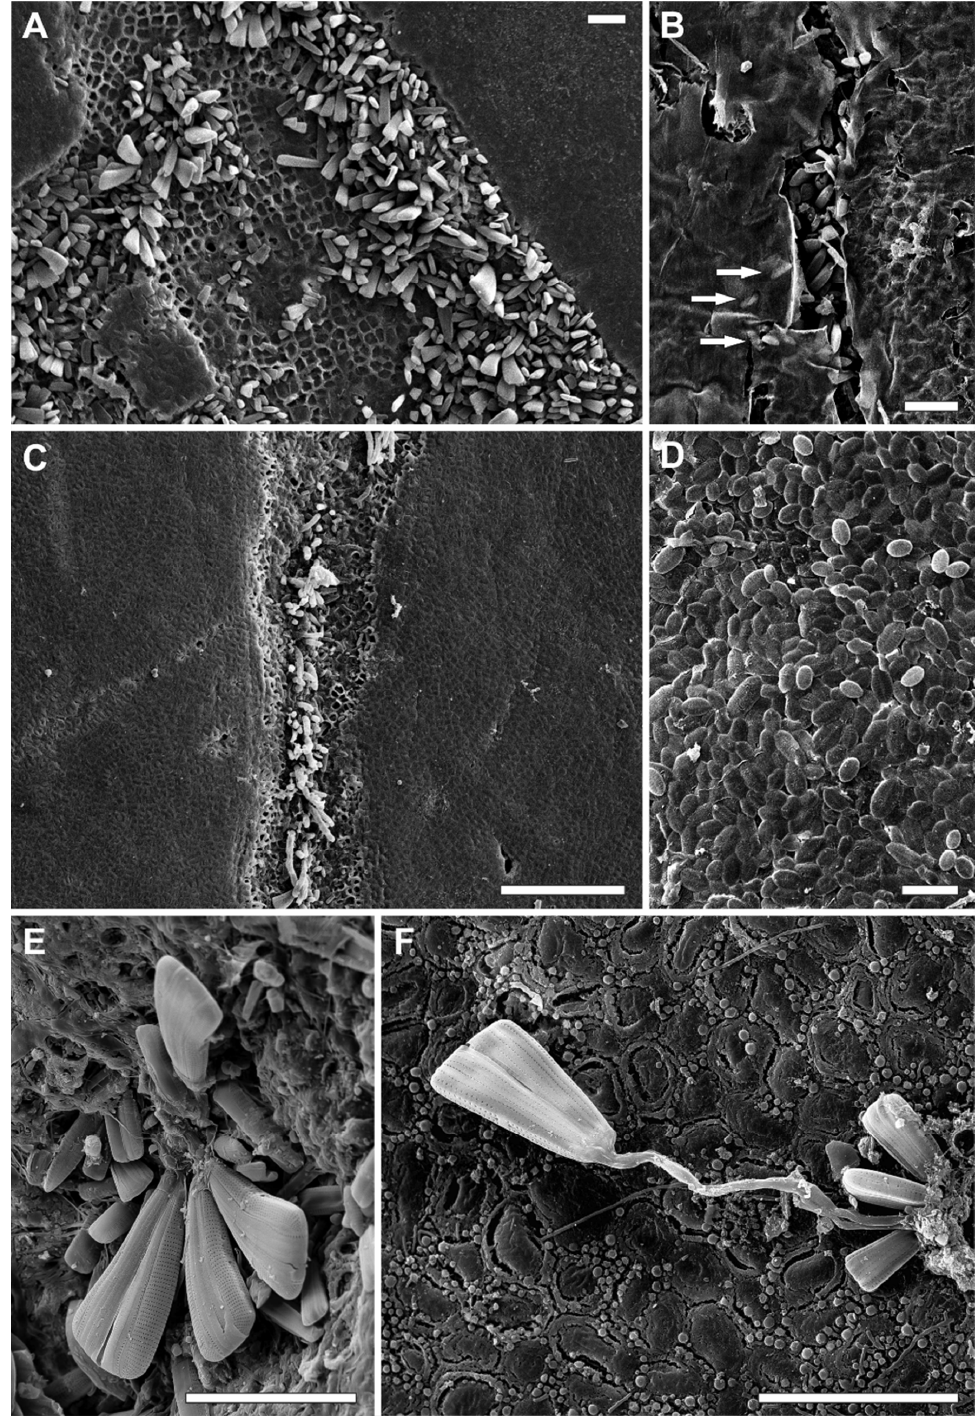
Figure 3. Scanning electron microscope (SEM) micrographs showing diatom assemblages on South African kelps. ( A – C and E ) Diatoms colonising cracks in the surface layer. ( B ) Diatoms underneath the flaking kelp tissue. Arrows indicate diatoms completely covered by the thin sloughing layer. ( D ) Cocconeis costata colonising the smooth surface of the kelp thallus. ( E ) Rhoicosphenia flexa , Gomphoseptatum pseudoseptatum , and Navicula sp. ( F ) Gomphoseptatum pseudoseptatum. Scale bars: A, B and D–F = 20 µm; C = 100 µm.